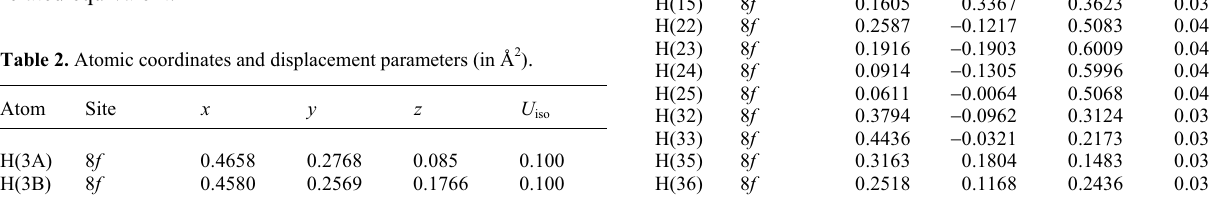
Table 3. Atomic coordinates and displacement parameters (in Å 2 )